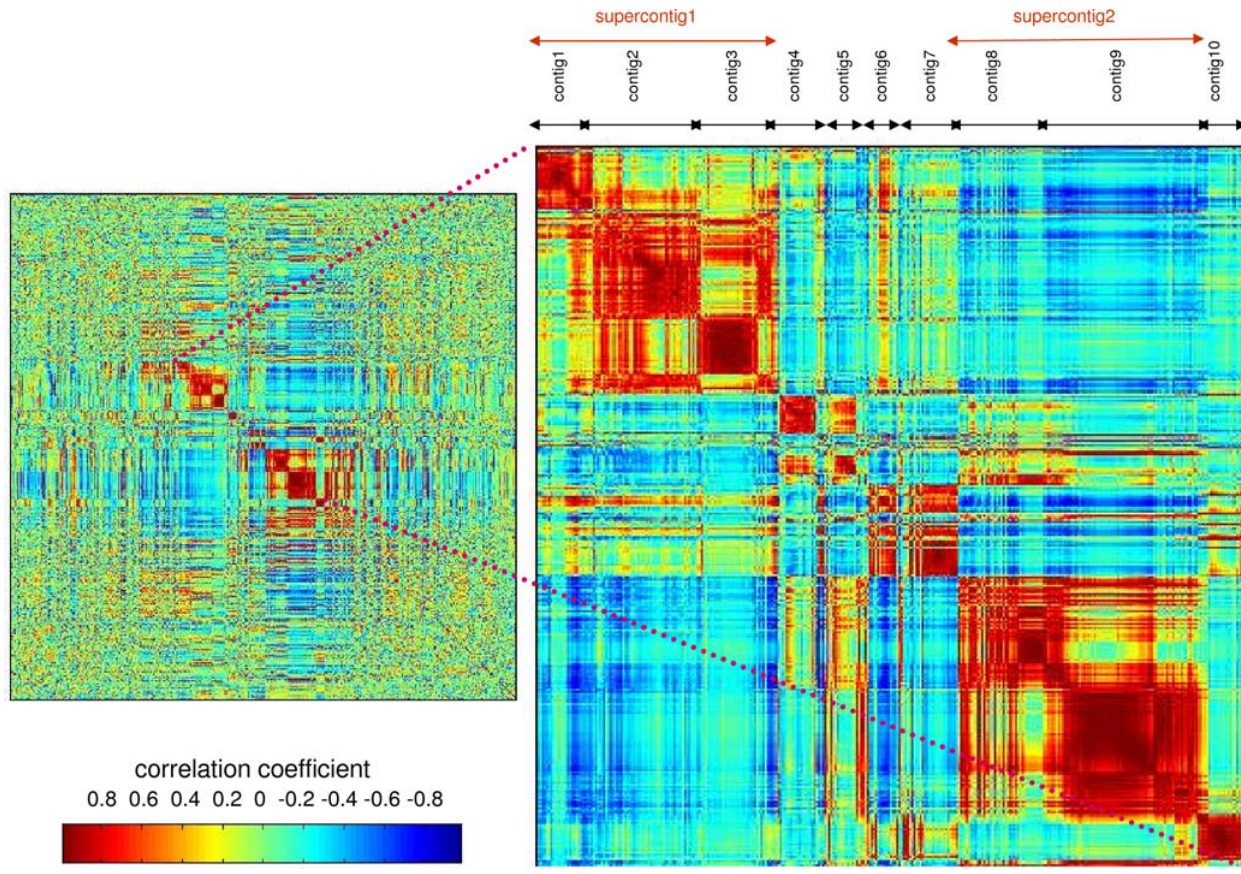
Figure 2. Seriation of genes expressed in mouse retinal SAGE libraries. SAGE data from Blackshaw et al. [20] were subjected to seriation analysis as described in the text. The resulting reordered correlation matrix containing correlation coefficients for each tag pair computed to measure the similarity of their retinal expression profiles is color-coded red to blue to represent decreasing correlation values. Ten contigs, including two supercontigs, recognizable as the squares of high (red) correlation values along the diagonal, are evident from the color-coded correlation matrix. The Figure on the right provides a zoomed-in view of the contigs.